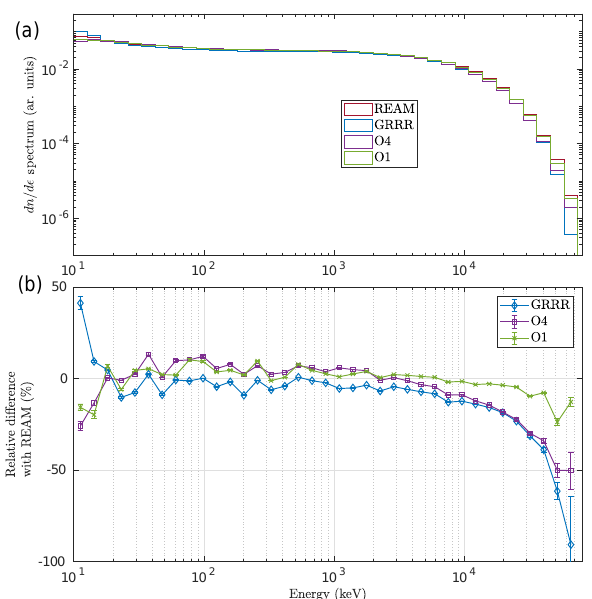
Figure 7. (a) Electron (kinetic) energy spectra of Geant4 (O4 and O1), REAM and GRRR for E = 0 . 80MVm − 1 , recorded at z = 128m. The RREA is generated from 200 seed electrons of (cid:15) = 100keV. (b) Relative difference between REAM and the three other models. The error bars are calculated from the Poisson statis-